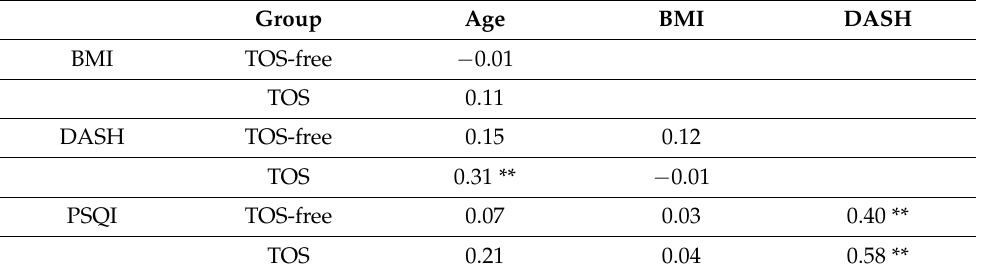
Table 5. DASH and PSQI scores in relation to age and